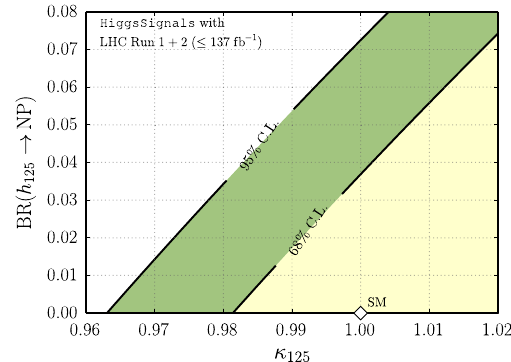
Fig. 2 ConstraintsfromHiggssignalratemeasurementsontheparam- eters κ 125 and BR ( h 125 → NP ) as obtained from HiggsSignals -